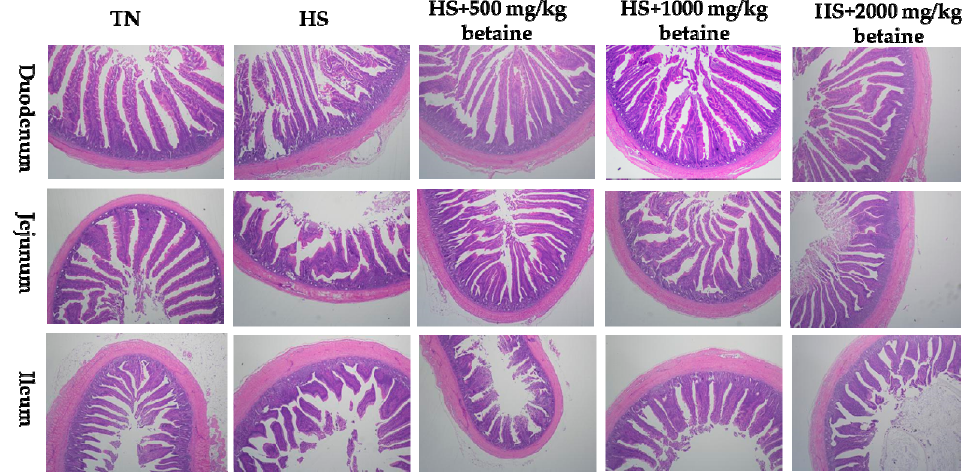
Figure 1. Photomicrographs of the effects of dietary betaine on intestinal morphology of yellow-feathered broilers after 5 weeks of heat stress (Stained with hematoxylin and eosin; TN, thermoneutral zone; HS, heat stress).